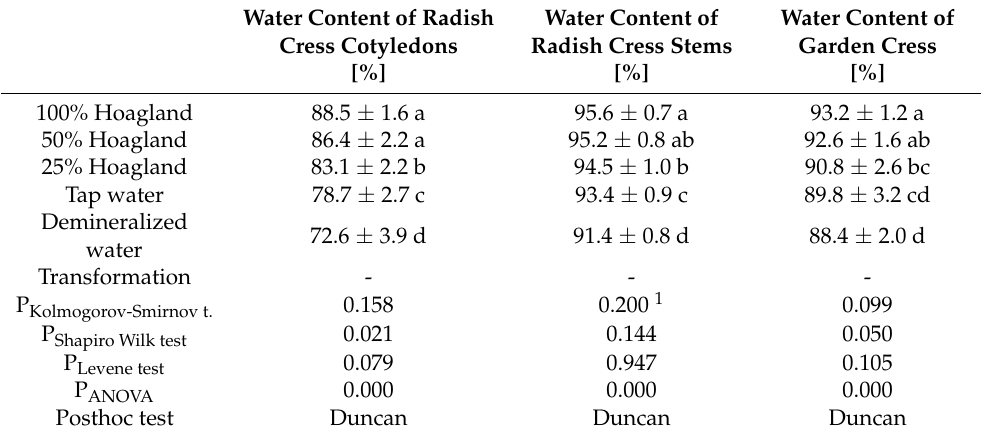
Table 5. Relative water content of garden and radish cress. Different letters within a column indicate significant differences.